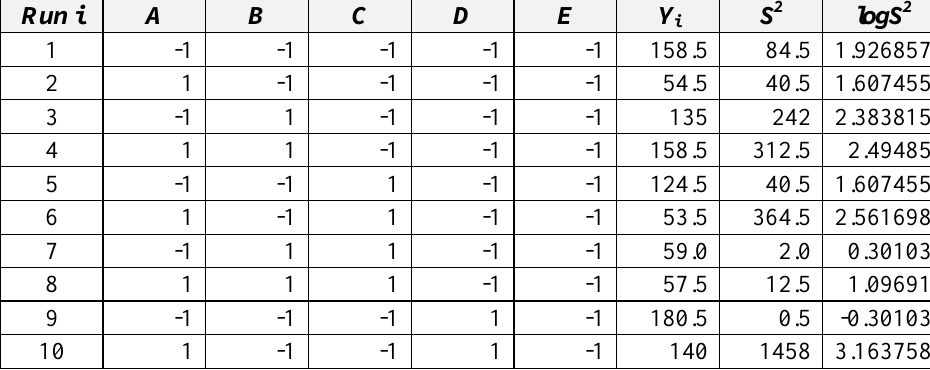
Table 2 - Process factor levels used Factor Symbol Level -1 of the factor Level +1 of the factor Casting